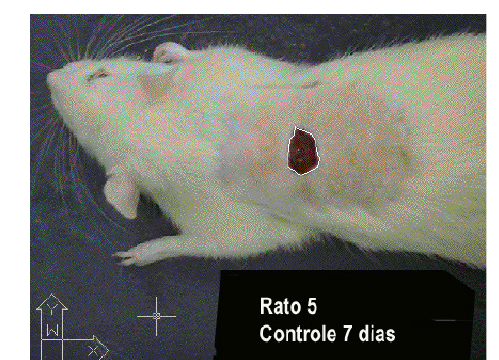
FIGURA 1 – Aspecto da área cirúrgica no dorso do animal digita - lizada para análise no software Auto Cad